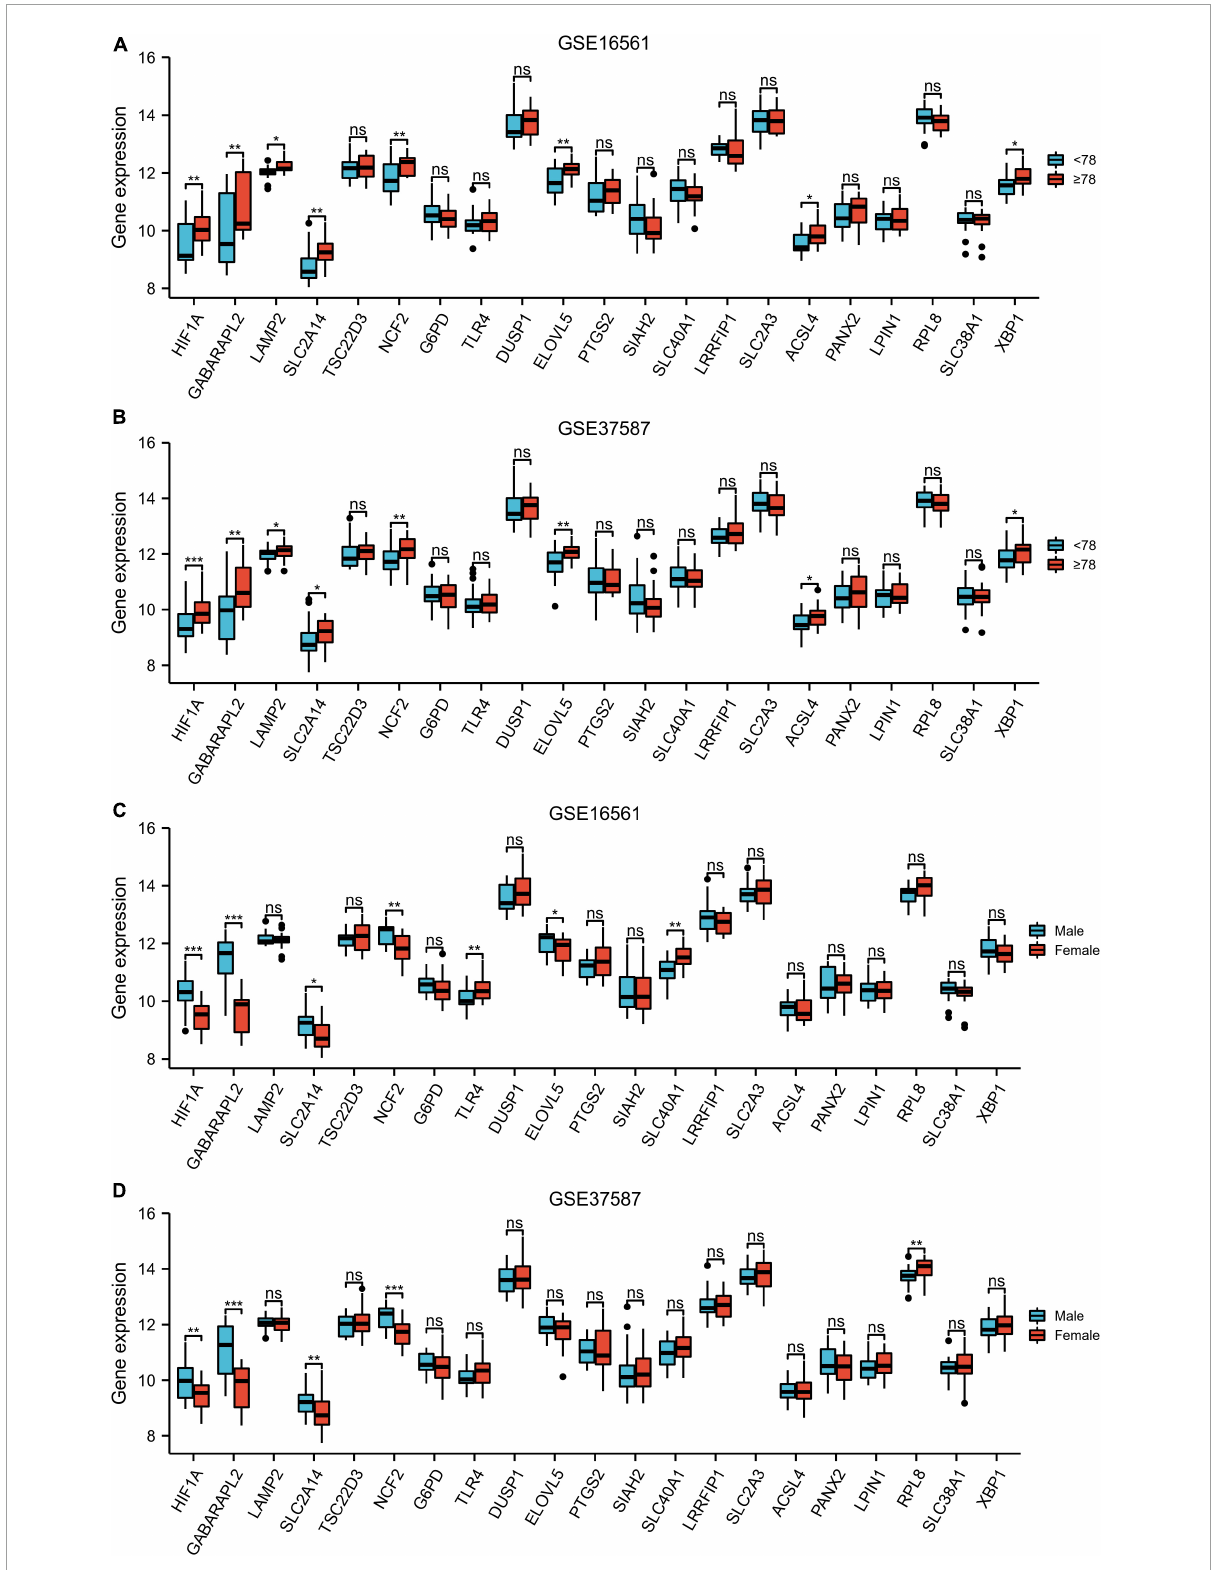
FIGURE5 Clinical correlation analysis. Box plot showing the expression pattern of the 21 ferroptosis-related genes between < 78 and ≥ 78 patients in GSE16561 (A) and GSE37587 (B) . Box plot showing the expression pattern of the 21 ferroptosis-related genes between male and female patients in GSE16561 (C) and GSE37587 (D) . ns: p ≥ 0.05, * p < 0.05, ** p < 0.01, and *** p <